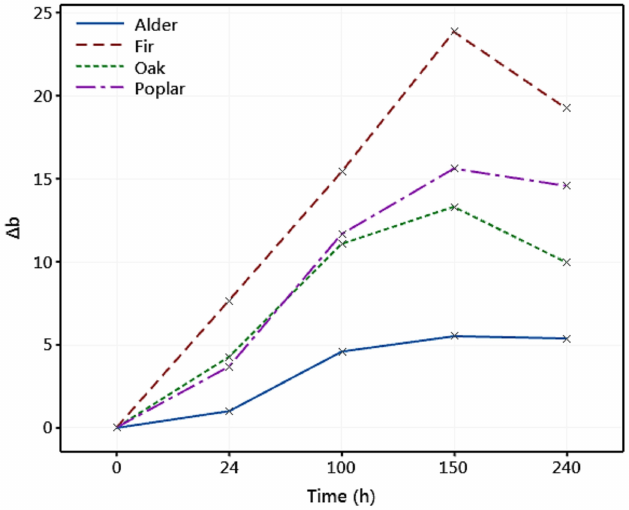
Figure 7. Variation in the yellowness ( ∆ b ) of different wood species exposed to artificial weathering. The variation in the redness ( ∆ a ) of the degraded wood samples is shown in Figure